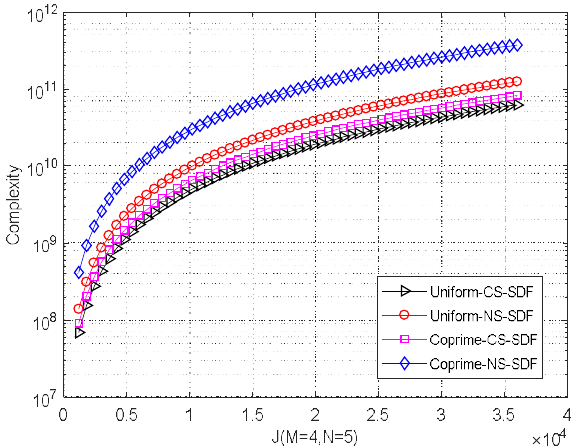
Figure 6. Complexity comparison with different grid number. Uniform-CS-SDF: SDF for CS based on uniform array; Uniform-NS-SDF: SDF for NS based on uniform array; Coprime-CS-SDF (proposed): SDF for CS based on coprime array; Coprime-NS-SDF (proposed): SDF for NS based on coprime